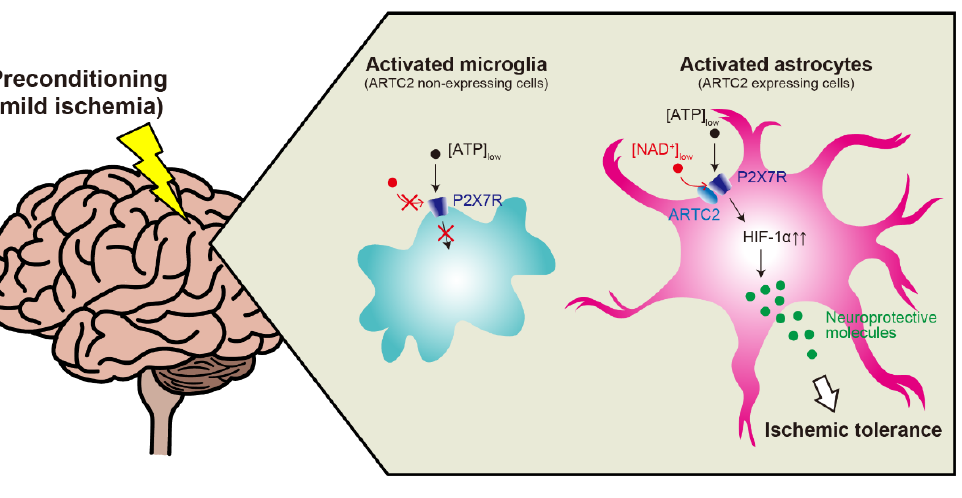
Figure 1. Schematic diagram of the mechanisms underlying P2X7 receptor activation in astrocytes and microglia.